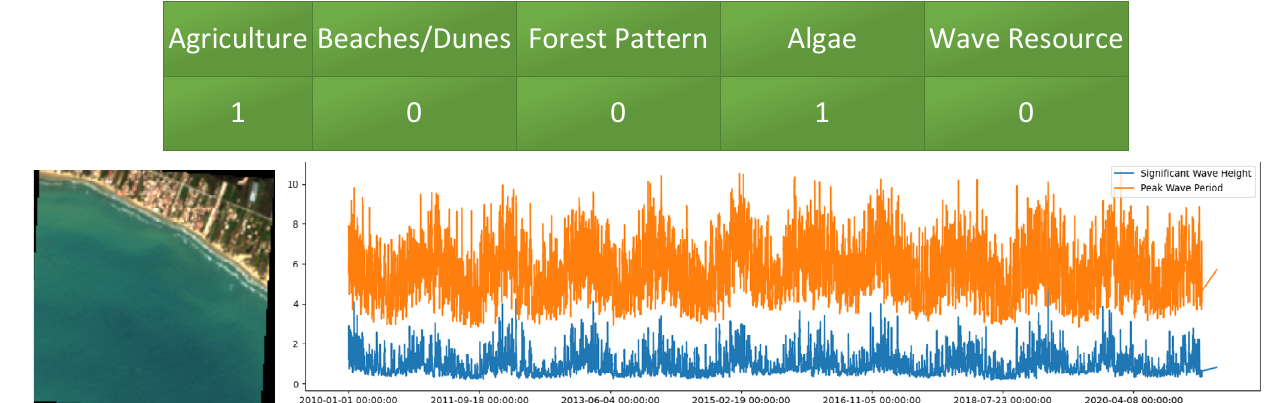
Figure 4. Example of One-Hot vector for unsuitable region.